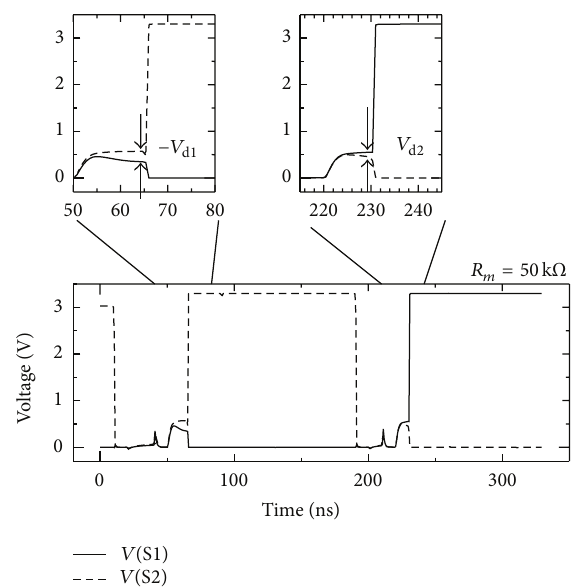
Figure 9: Simulation results for the recall operation. 𝑅 𝑚 , 𝑅 𝑅 were fixed at 50, 100, and 65k Ω , respectively. refb